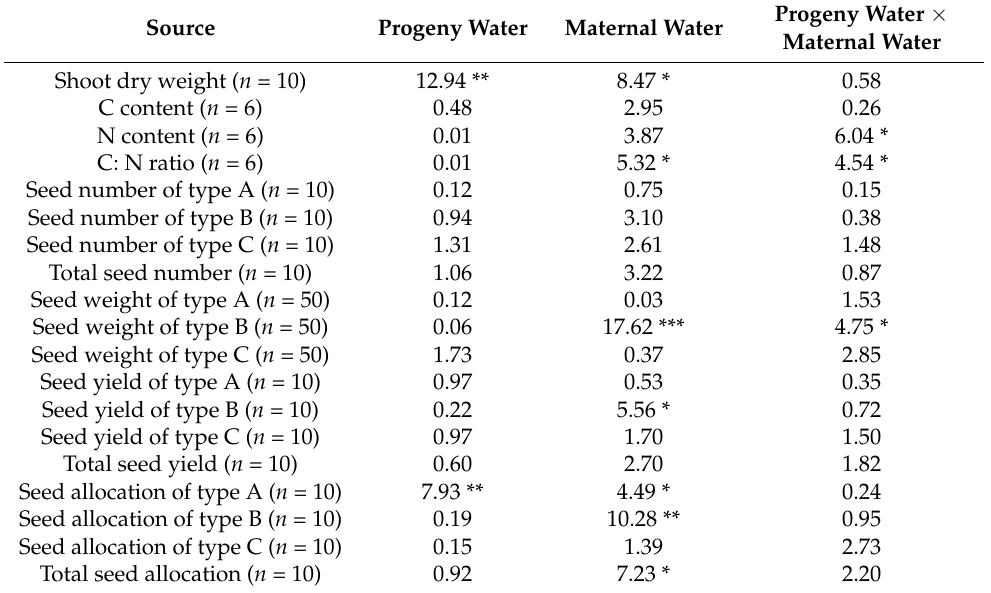
high water treatment, compared with plants with maternal low water treatment, the shoot dry weight of plants with high maternal water treatment increased 18.2% (Figure 1). Table 1. F values from two-way ANOVA for the effects of progeny water, maternal water, and their interactions on investigated properties of Atriplex aucheri .